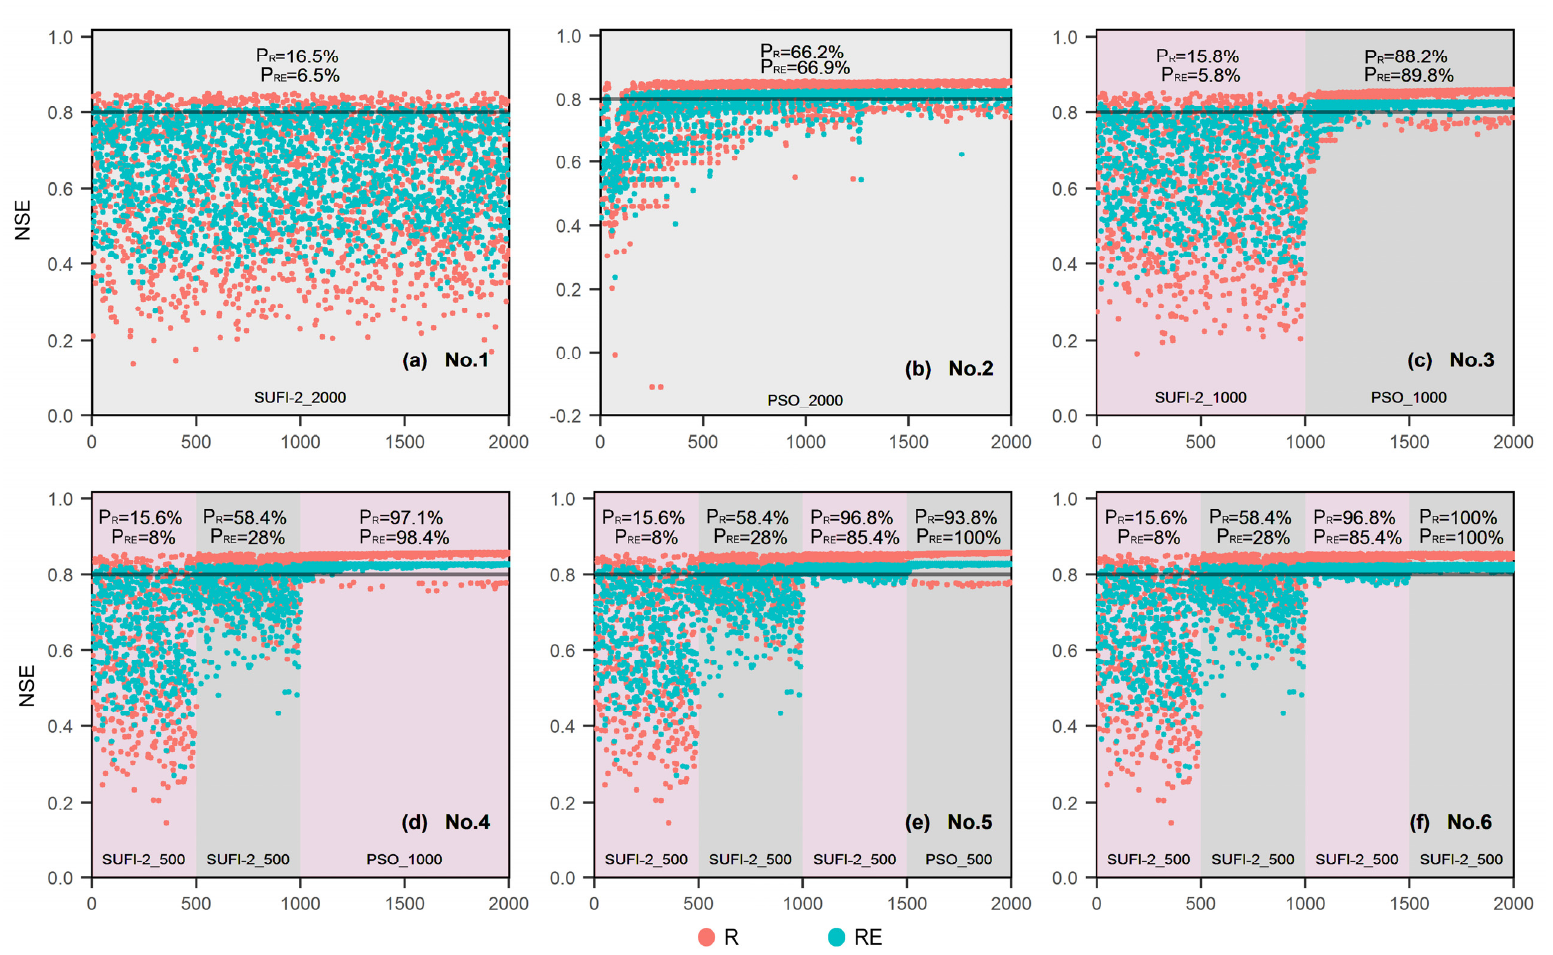
Figure 6. Dot-plots of NSE against different methods and running times under different approaches (i.e., approaches No.1 to 6 as listed in Table 2). Values denoted as PR or PRE in each panel indicate the percentage of the NSE > 0.8. X axis means the running time, and Y axis indicates the NSE value. The red dots represent use of observed streamflow only, and teal dots represent use of observed streamflow and remotely-sensed ET. ( a – f ) were the codes of 6 approaches.